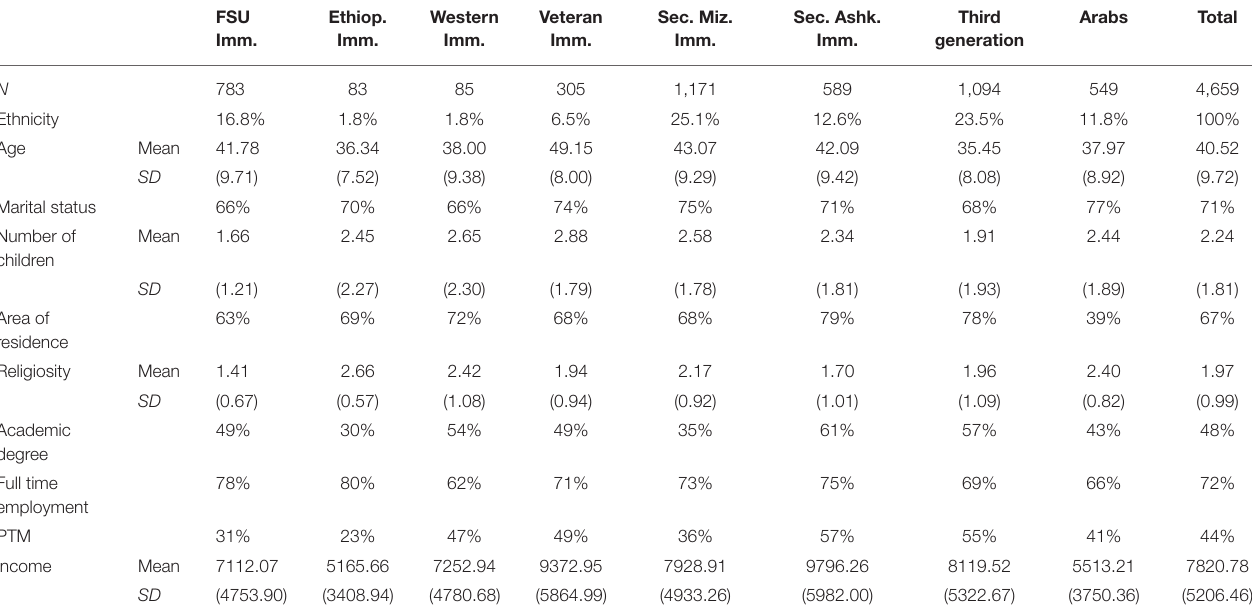
TABLE 1A | Socio-demographic characteristics of the sample—Women.